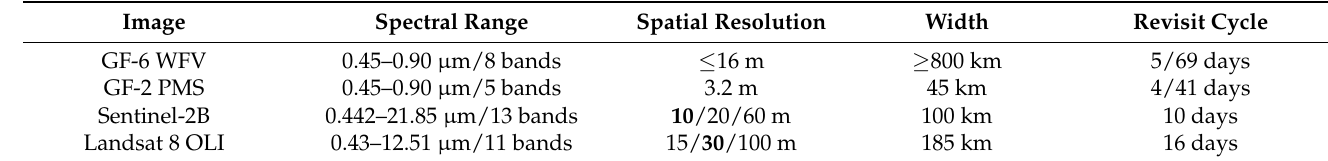
Table 1. Information about image data.